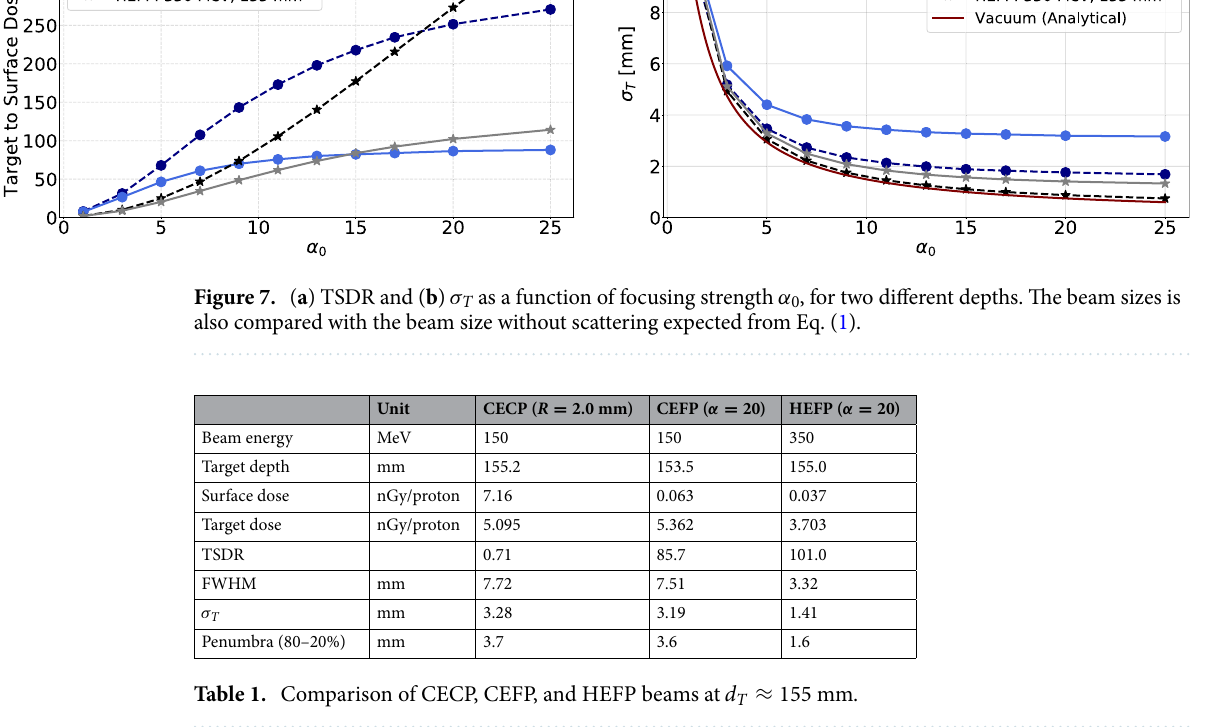
Table 1. The focused protons will move at an angle relative to the principal horizontal direction, where the initial beam